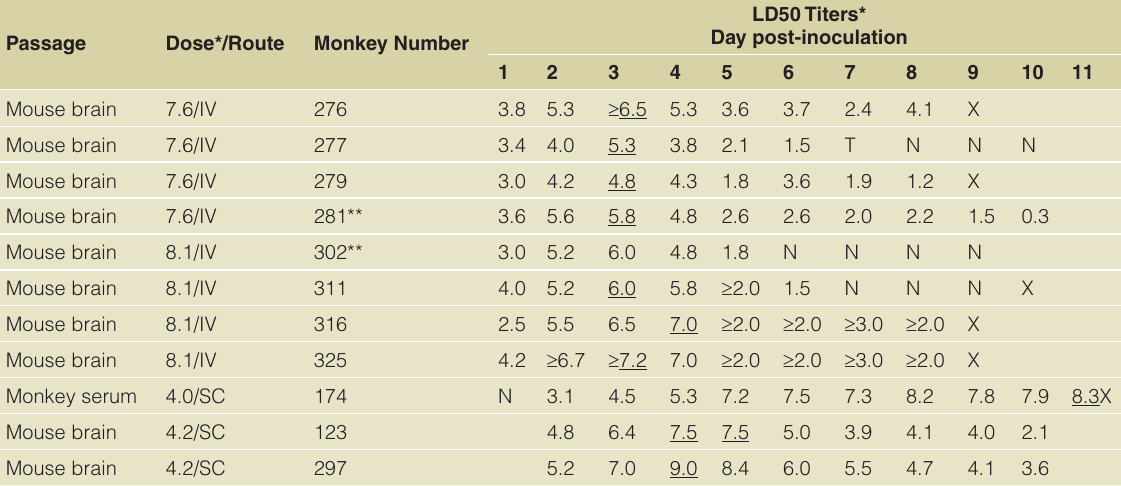
Table 3. Infection and mortality in the bonnet macaque with virulent KFDV. * Positive logarithms of adult mouse LD50 titers/0.03 ml.